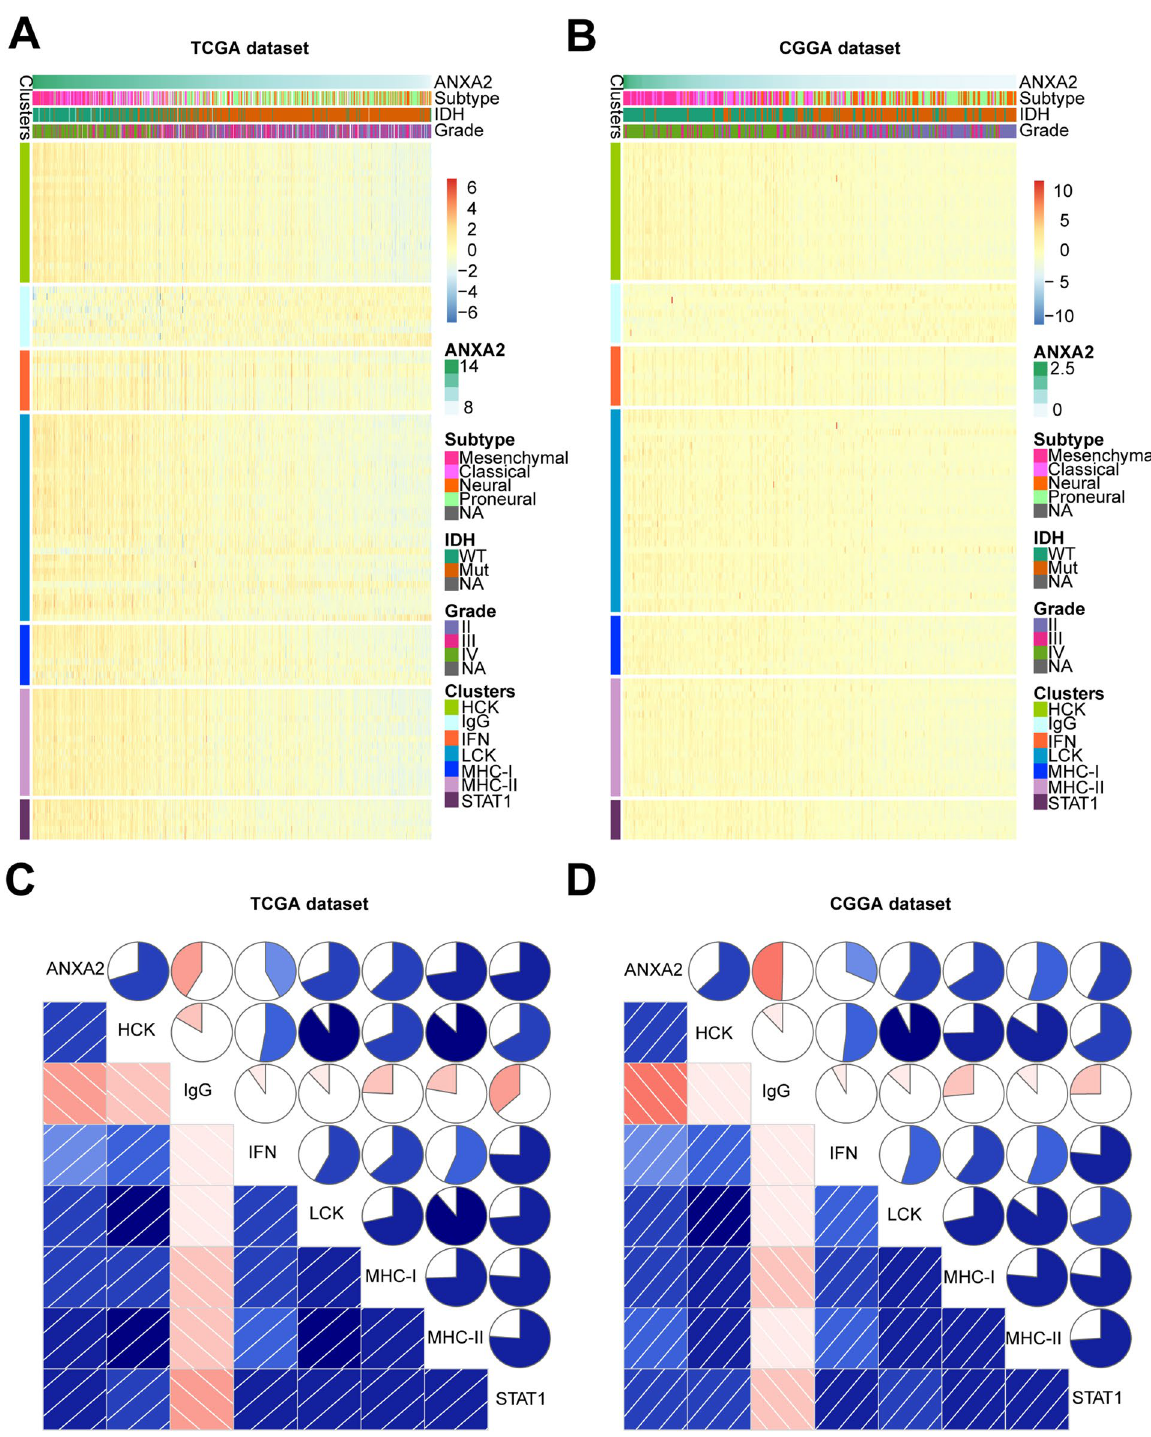
Figure 7. ANXA2-related inflammatory activities in glioma. The relationship between ANXA2 and WHO grade, IDH status, molecular subtypes and inflammatory metagenes are presented as a heatmap in TCGA and CGGA databases ( A,B ). Correlograms showed the correlation between ANXA2 and inflammatory metagenes ( C,D ). Blue represents positive correlations, and red represents negative correlations. Color intensity and the size of the circle in pie charts are proportional to the correlation coefficients. The results indicated that ANXA2 was significantly positively correlated with most inflammatory